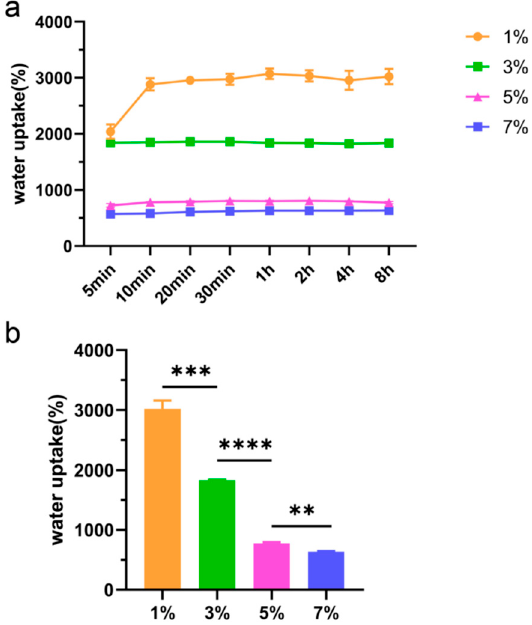
Figure 5. ( a ) Variation curve of water uptake rate of freeze-dried chitosan scaffolds with different concentrations over time, n = 3; ( b ) Statistical chart of water uptake rate after water saturation of freeze-dried scaffolds with different concentrations of chitosan, n = 3, ** p < 0.01, *** p < 0.001, **** p < 0.0001.